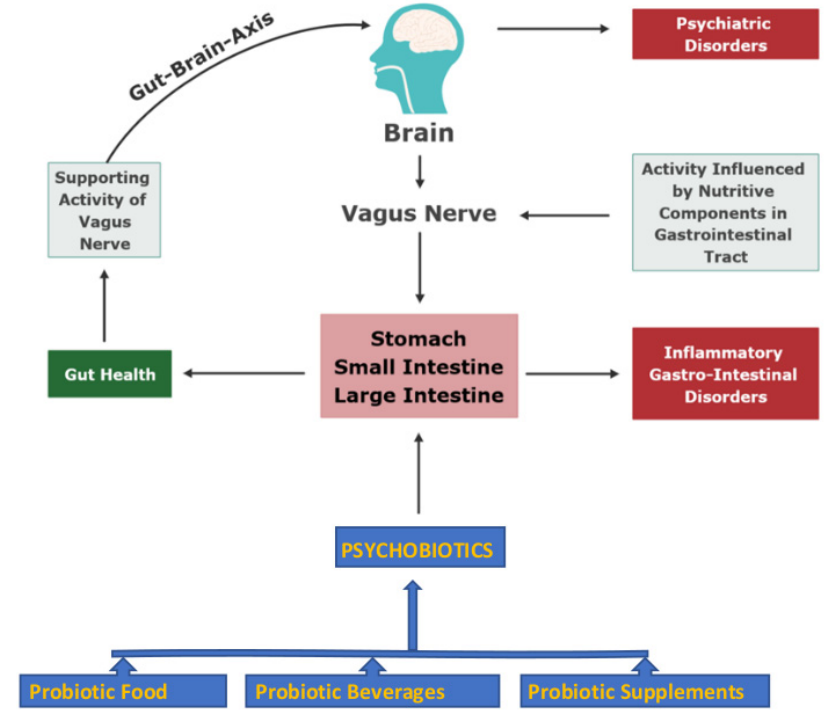
Figure 1. Psychobiotics in nutrition improve gut and brain health via the microbiome–gut–brain axis (Figure is drawn by authors Dahiya and Nigam). The consumption of probiotic products act as psychobiotics, where the microbiota-driven gut–brain axis reflects an interaction between the central nervous system and the intestine through the vagus nerve. Detailed information is available in references [1–4] for the boxes Probiotic food, Probiotic beverages, and Probiotic supplements.